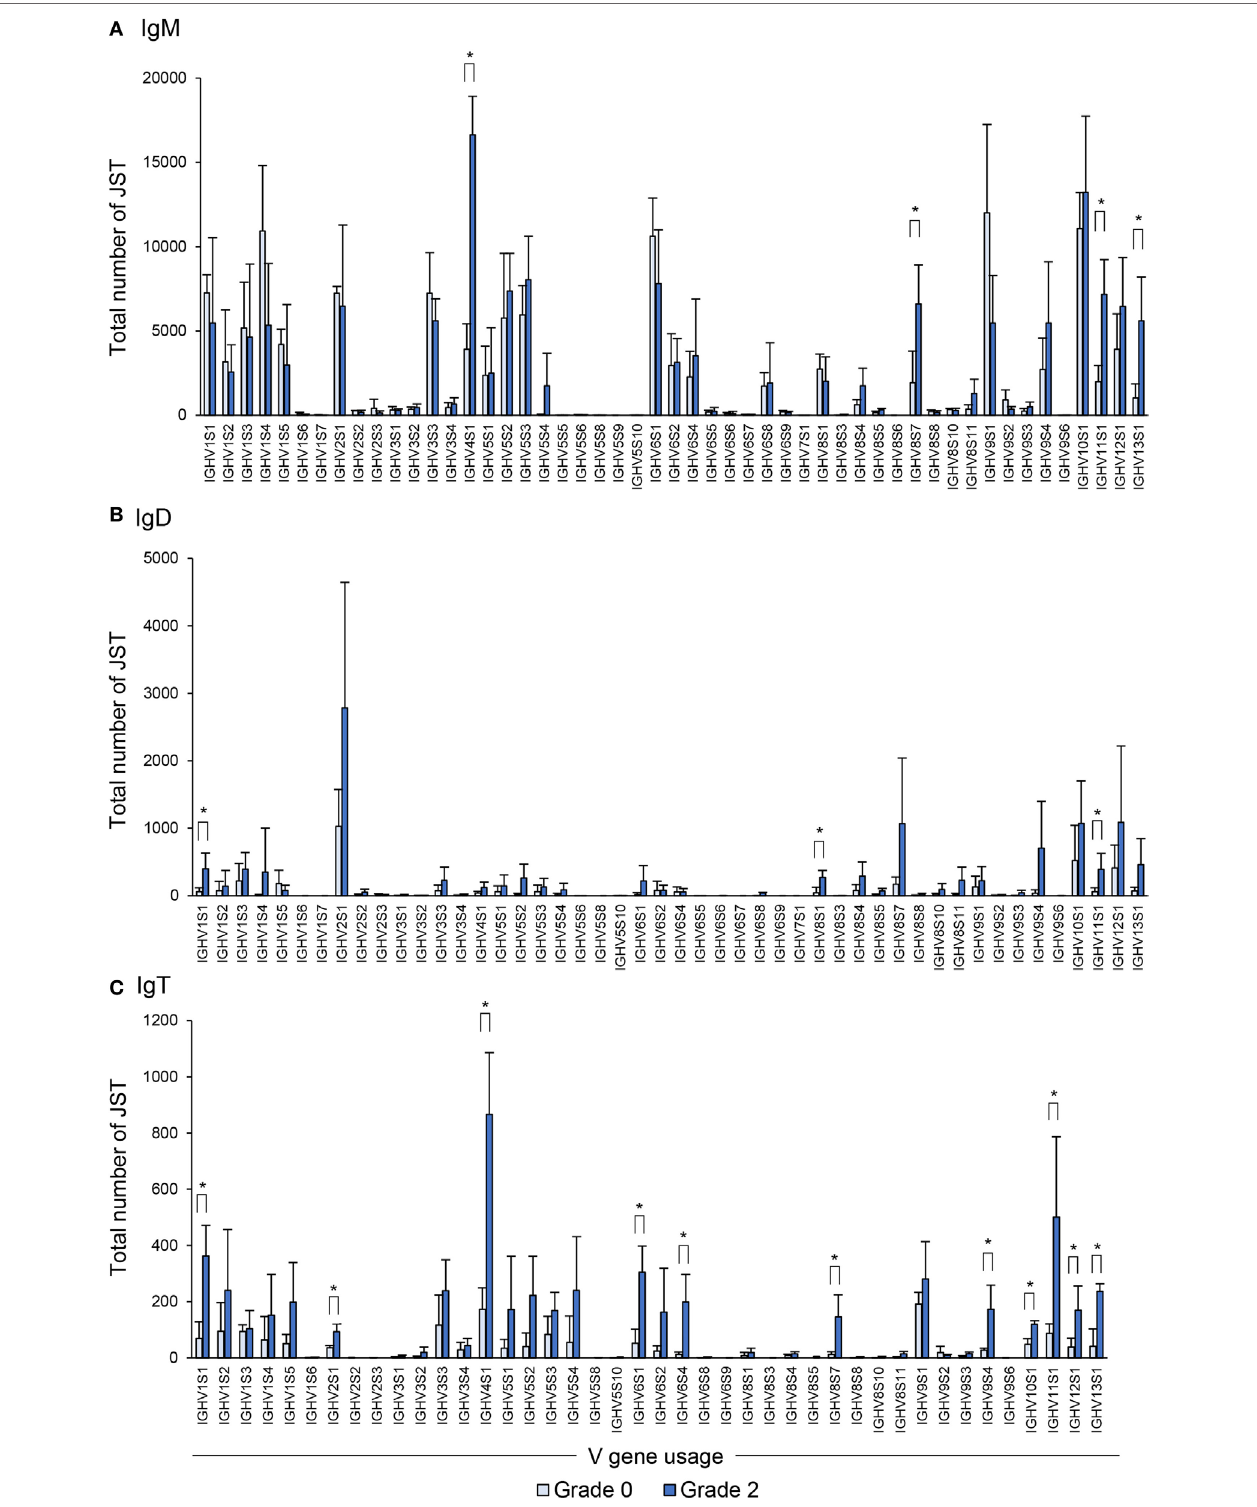
FigUre 8 | Differential usage of germline immunoglobulin (Ig) VH­gene segments during the B cell response to proliferative kidney disease. Bar charts show the average number (mean + SD) of unique sequences [V(D)J­CDR3(AA)] defined as junction sequence types (JST) identified for IgM (a) , IgD (B) , and IgT (c) for each VH family in grade 0 kidneys compared with grade 2 ( n = 4). Statistical differences ( P < 0.05) between the two groups (analyzed with a two­tailed Student’s t ­test) are shown with an